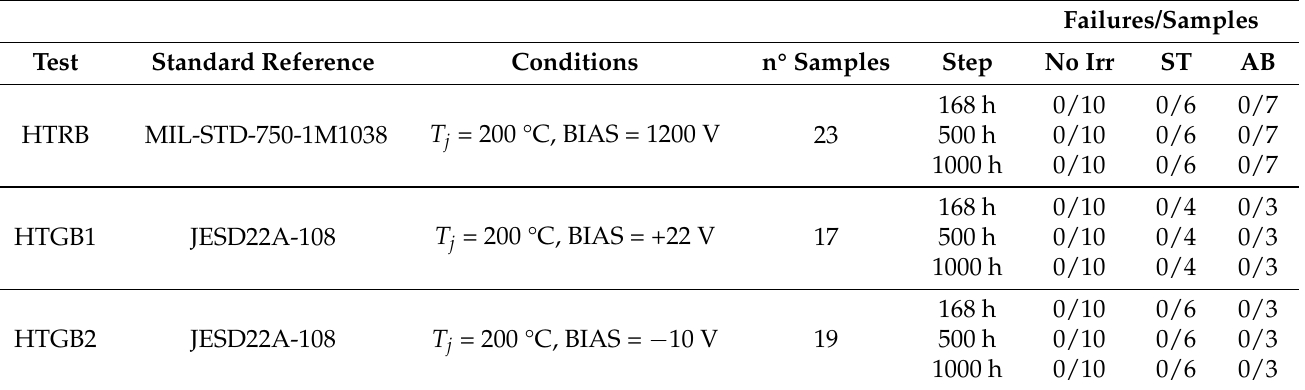
Table 4. HTRB and HTGB tests results of the GEN3 SiC MOSFETs.